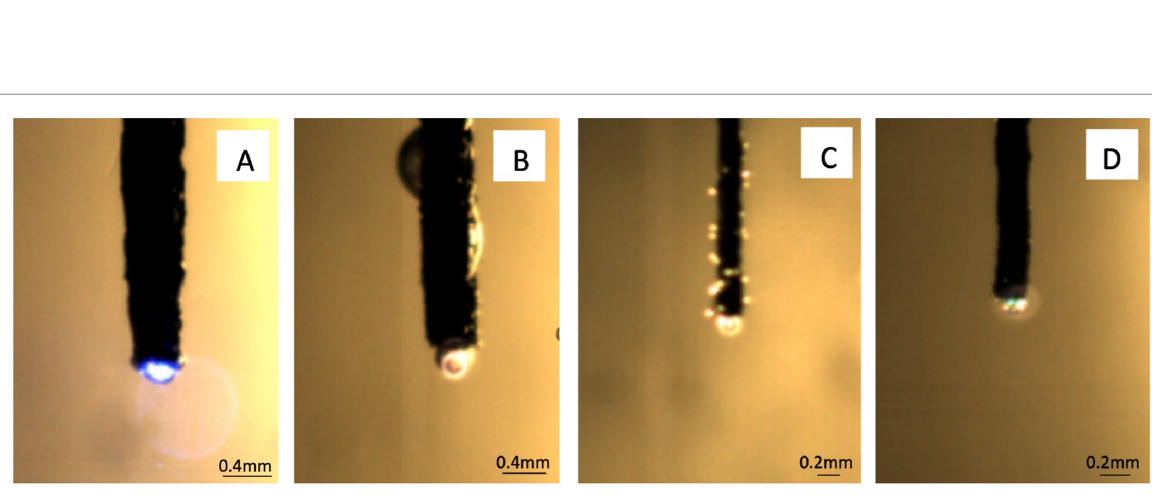
FIGURE 2 Laser tips activated submerged in deionized water, frame length 3,860 μ s for diode lasers. ( A ) SIROLASE 455 nm with 67% DC, 0.8 W, 15 Hz; ( B ) SIROLASE 970 nm with 67% DC, 0.8 W, 15 Hz; ( C ) WISER 808 nm with 1 W, 15 Hz, 67%; ( D ) WISER 980 nm with 1 W, 15 Hz,